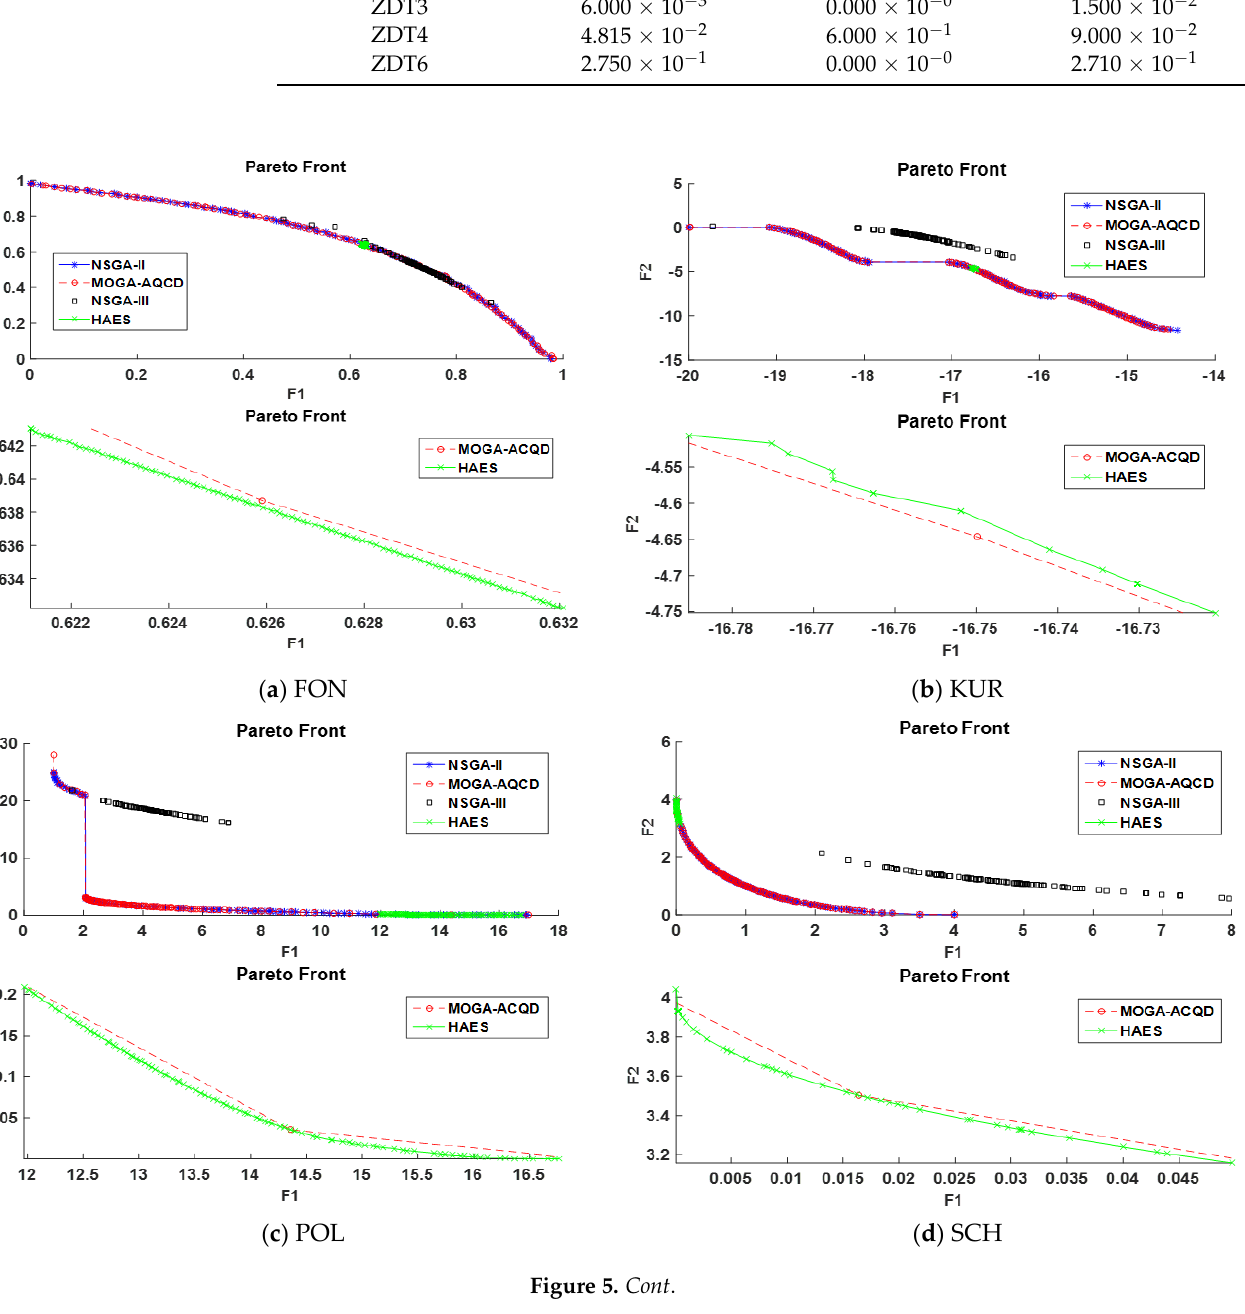
solutions found by HAES at the bottom. The Pareto front was lower for the functions FON, POL, SCH, ZDT1, ZDT2, ZDT3, and ZDT4, which is more domination with respect to